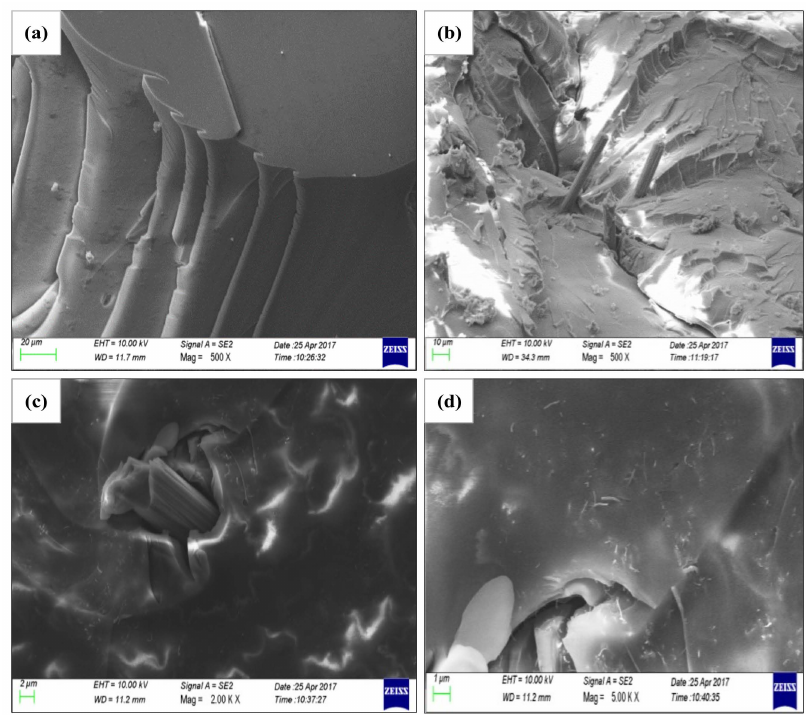
Figure 7. Mechanical Section of CNTs / CF / EP composites from SEM. ( a ) EP ( b ) CF / EP composites ( c , d ) CNTs / CF / EP composites